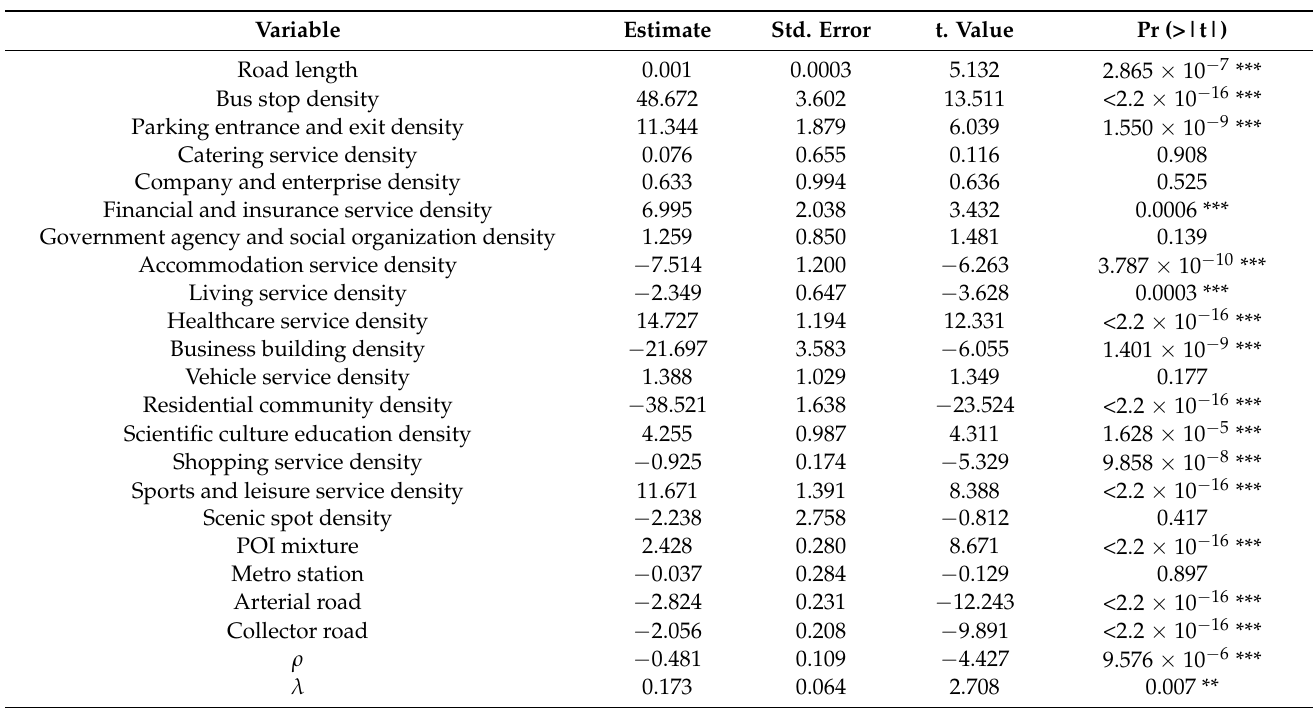
Table 2. Results of Spatial Panel Data fixed-effects